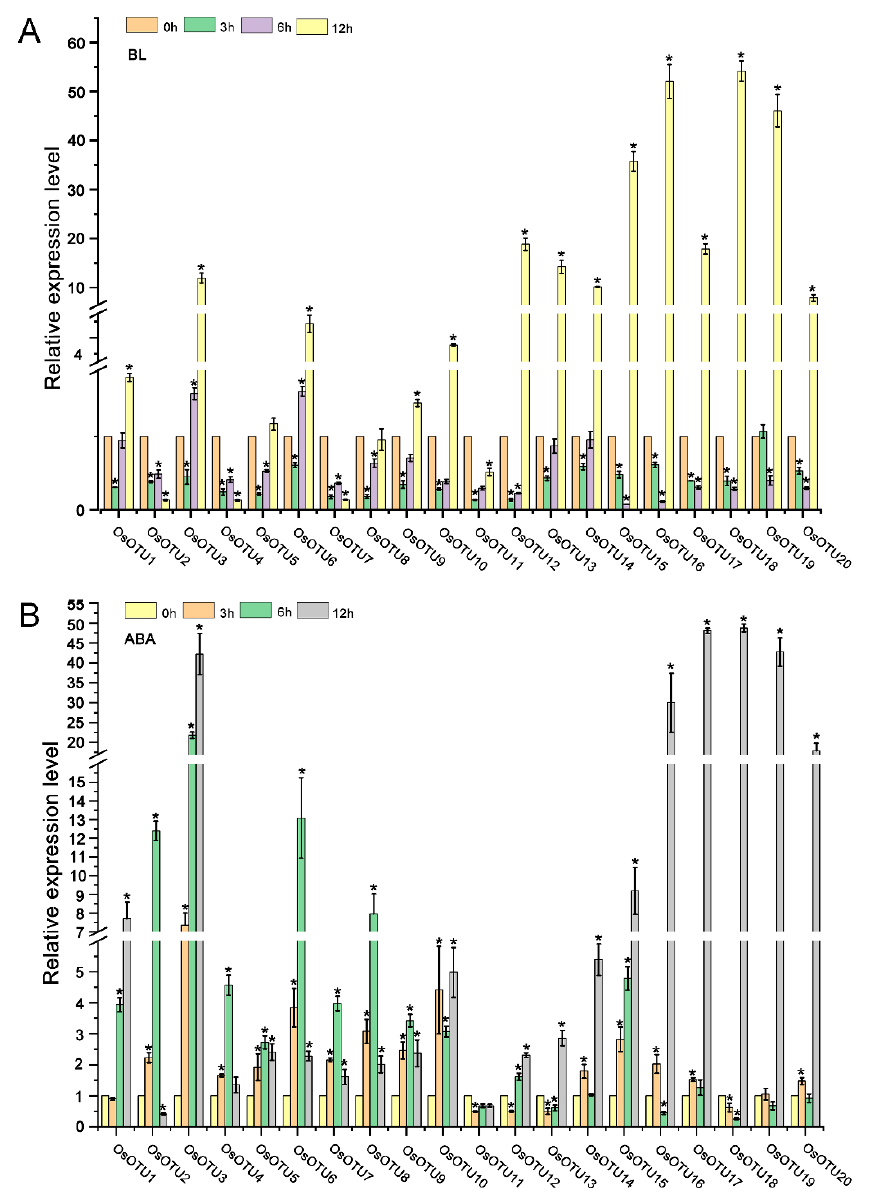
Figure 7. The expression pattern of OsOTU genes under different hormone treatments. Plants were treated with BL (10 µ M) ( A ), ABA (50 µ M) ( B ). Samples were collected at 0, 3, 6, and 12 h. The OsUBQ5 gene was the reference gene used to calibrate the relative gene expression. Error bars represent ± SE ( n = 3). One-way analysis of variance was conducted by Duncan’s new multiple-range test, n = 3. * indicates significant differences from the mock control at p ≤ 0.05 by Fisher’s least significant difference tests.